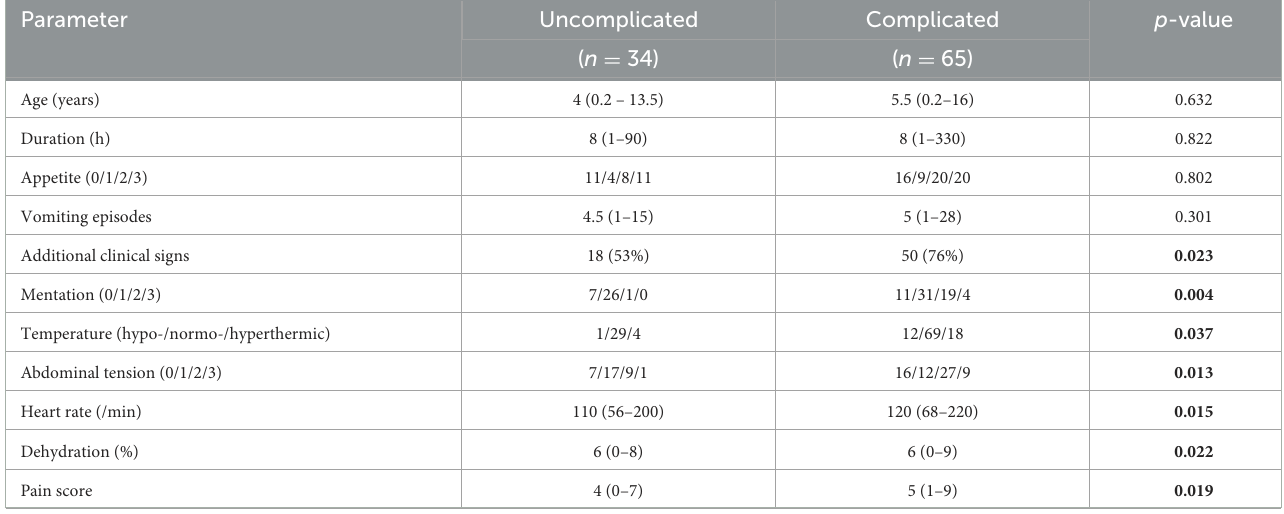
TABLE 4 Comparison of demographic, anamnestic, and clinical parameters of 34 dogs with uncomplicated vomiting and 65 dogs with complicated